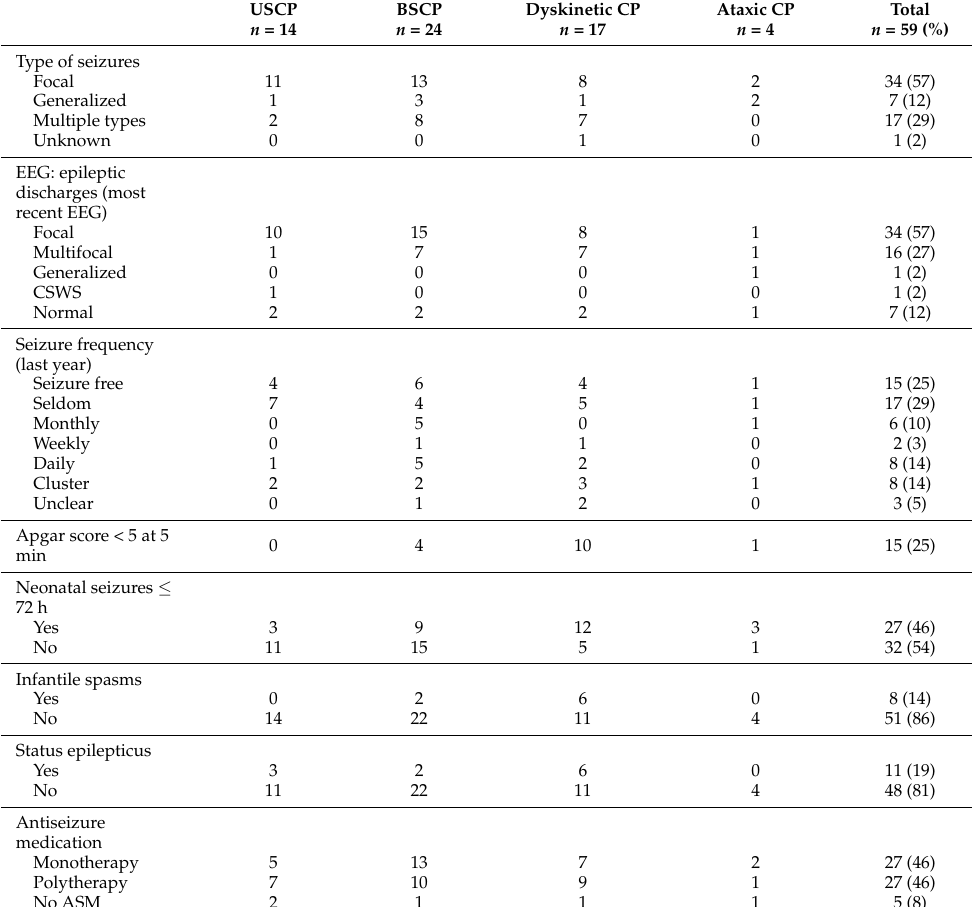
Table 2. Characteristics of epilepsy in 59 children with cerebral palsy (CP).